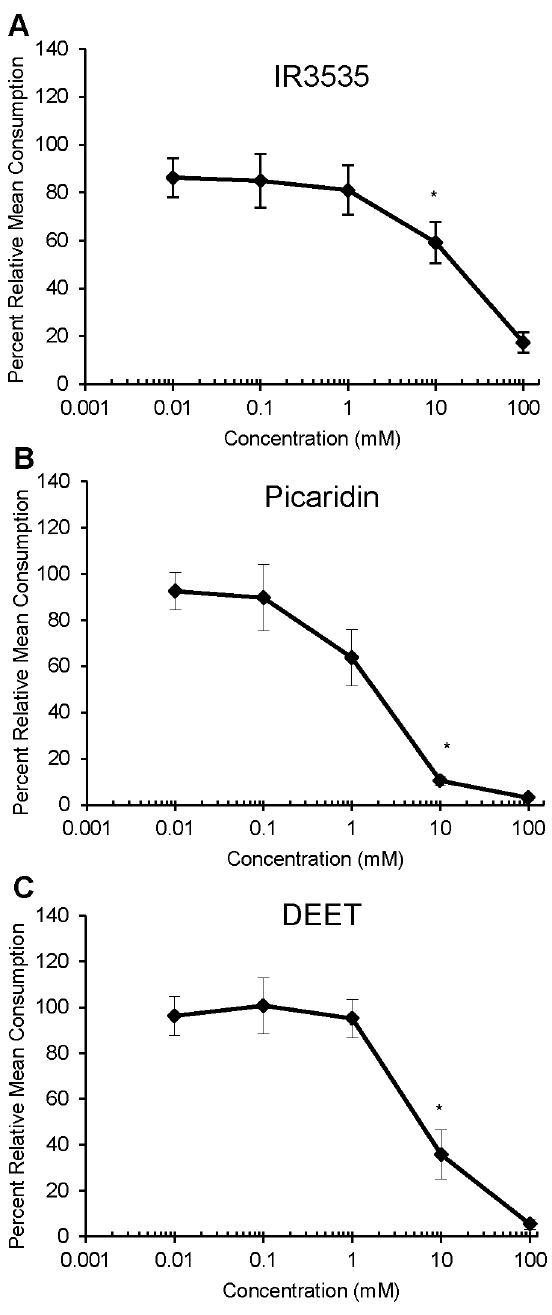
Figure 1. Dose response curves (in percent mean consumption) to increasing concentrations of (A) IR3535, (B) picaridin, and (C) DEET. Asterisks denote the concentration of repellent that significantly decreased feeding relative to the control. Vertical bars represent standard errors. (Fig. 5.A–C) (repeated measures ANOVA; post-hoc Tukey- Kramer analysis; a , 0.05; n =5–6 sensilla). Higher concentrations